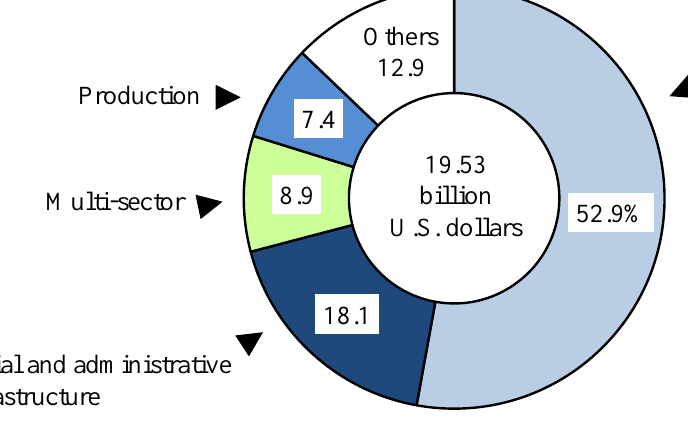
Distribution of Bilateral ODA by Sector 1) (2015)